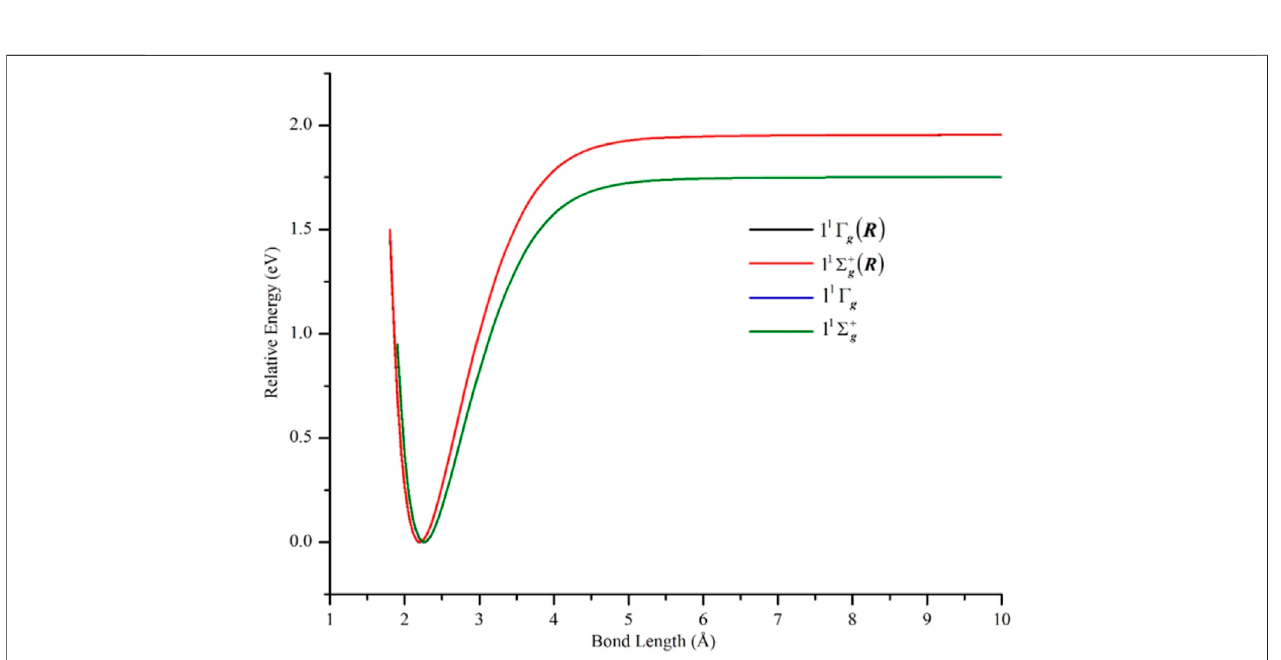
FIGURE4| PECsofthelowest-lying δδ – holeX 1 Γ g and1 1 Σ g+ statesofNi 2 computedattheGVVPT2leveloftheory,withandwithoutscalarrelativityincluded,using the cc-pVTZ (or cc-pVTZ-DK) basis set. Non-relativistic energies are plotted relative to the lowest energy value of the ground X 1 Γ g term while relativistic energies are plotted relative to the lowest energy of the X 1 Γ g (R) term.